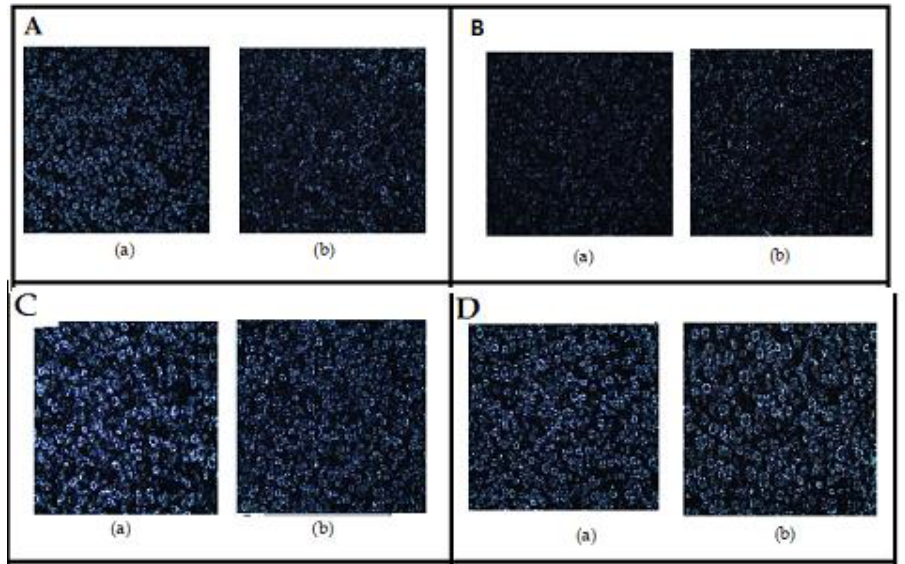
Figure 1. Formation of the liquid-crystal structure in Formulations A, B, C, and D ( a ) after 24 h (t0) and ( b ) after 90 days (t90). ( A )—base formulation containing only 4.0% Crodafos CES ® (cetearyl alcohol, dicetyl phosphate, and ceteth-10 phosphate); ( B )—formulation containing nano-actives from safflower, coconut, and clover oils; ( C )—formulation containing glycolic extracts of Centella asiática and Hamamelis virginiana leaves and Aesculus hippocastanum seeds; ( D )—formulation containing an association of nano-actives and glycolic extracts.